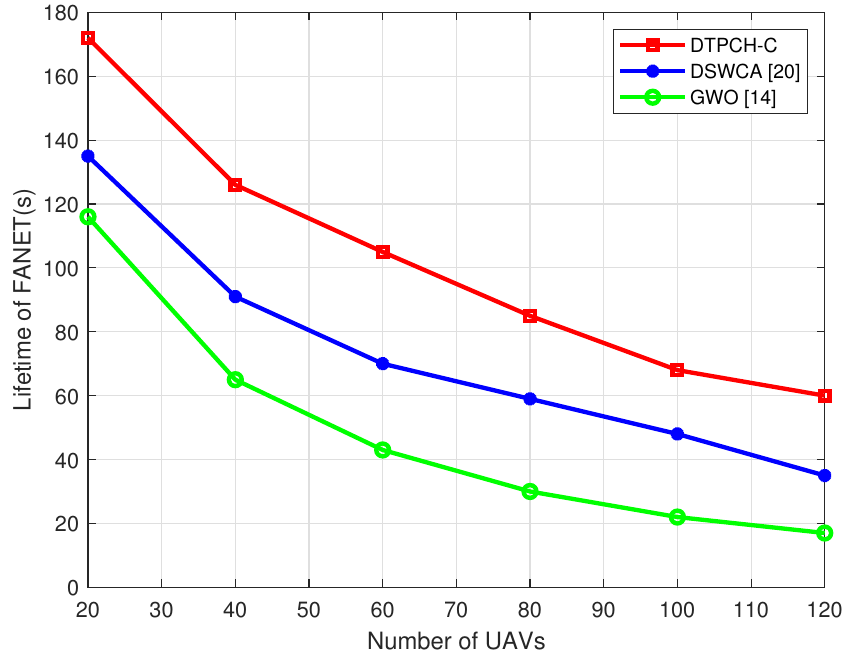
Figure 10. Lifetime of FANET in different clustering schemes versus the number of UAV